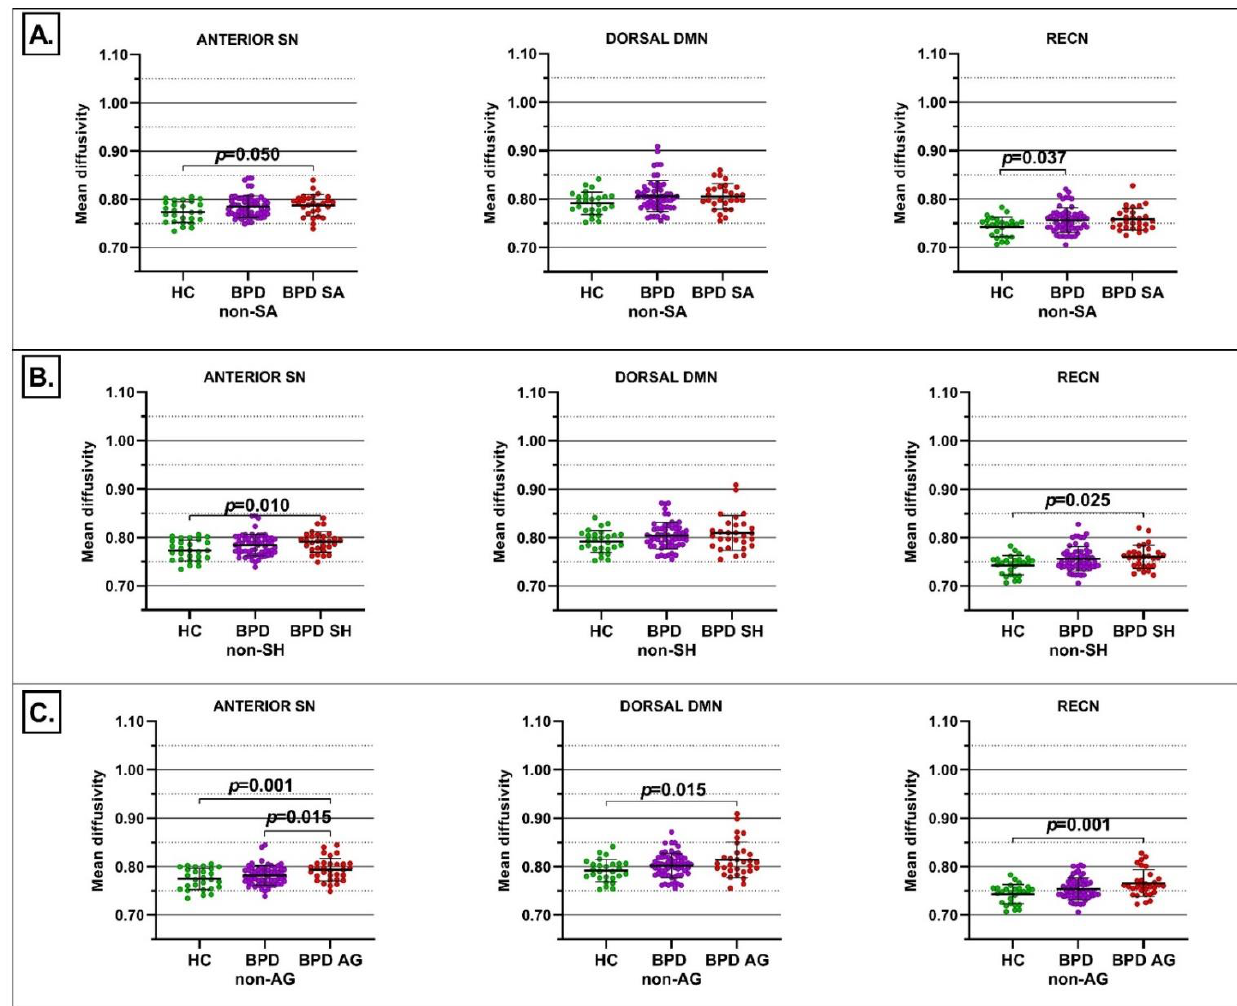
Figure 2. Differences in mean diffusivity of the anterior SN, dorsal DMN, and RECN between BPD patients with suicide attempts (BPD SA) and without suicide attempts (BPD non-SA) and HC (panel ( A )), between BPD patients with self-harm (BPD SH) and BPD without self-harm (BPD non-SH) and HC (panel ( B )), and between BPD patients with aggressive behaviors (BPD AG) and BPD without aggressive behaviors (BPD non-AG) and HC (panel ( C )). Each dot represents a subject, horizontal and vertical bars denote the mean and the standard deviation, respectively. p values denote the statistical significance, corrected for multiple comparisons using the Bonferroni method.